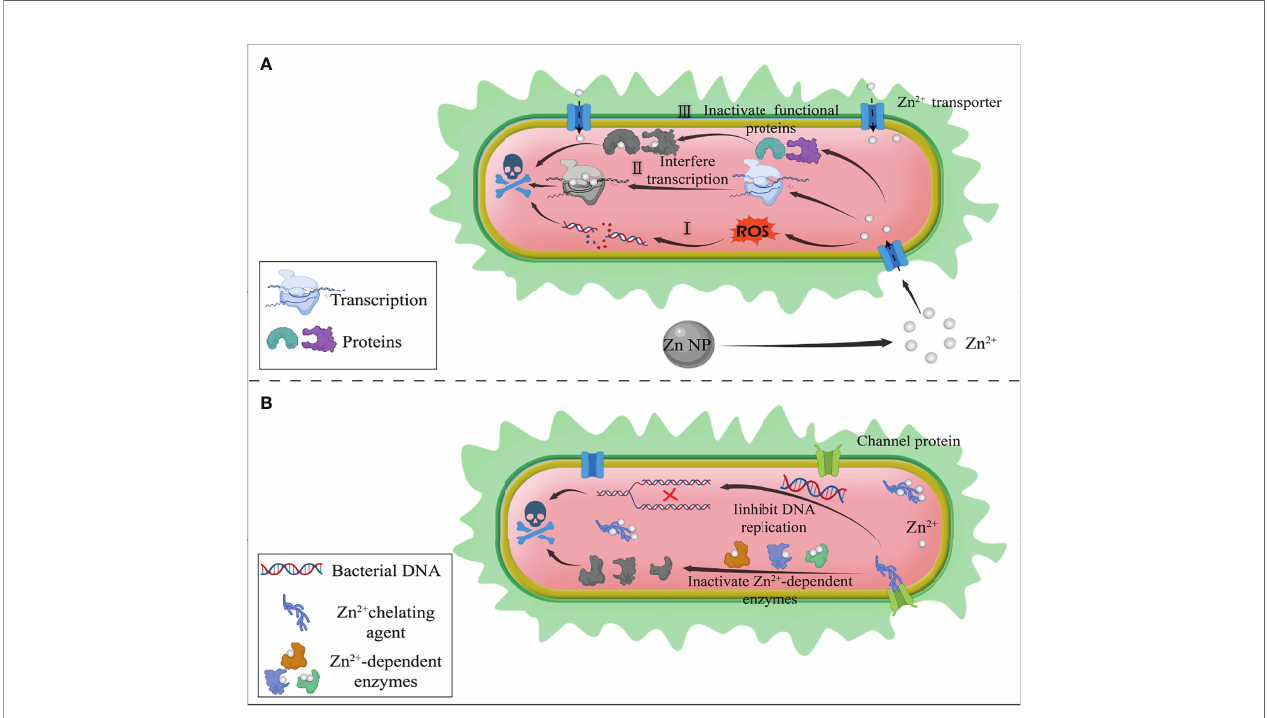
FIGURE 1 | Schematic diagram of the antibacterial mechanism of zinc ion interference therapy. (A) Zinc ion overloading strategy. Zinc-loaded nanodelivery systems release large amounts of zinc ions at the site of bacterial infection. The excess zinc ions produce the following antibacterial effects: I) interaction with the thiol group of bacterial respiratory enzymes resulting in the production of intracellular ROS, thus damaging bacterial DNA: II) interference with bacterial transcriptional regulation; III) inactivation of functional proteins leading to metabolic dysfunction of bacteria. (B) Zinc ion deprivation strategy. Zinc chelating agents deprive intracellular zinc ions, resulting in the imbalance of zinc ion homeostasis. The lack of zinc ions could lead to the inactivation of Zn 2+ -dependent enzymes, affecting the structure of chromatin and inhibiting the replication of DNA, thus causing bacterial